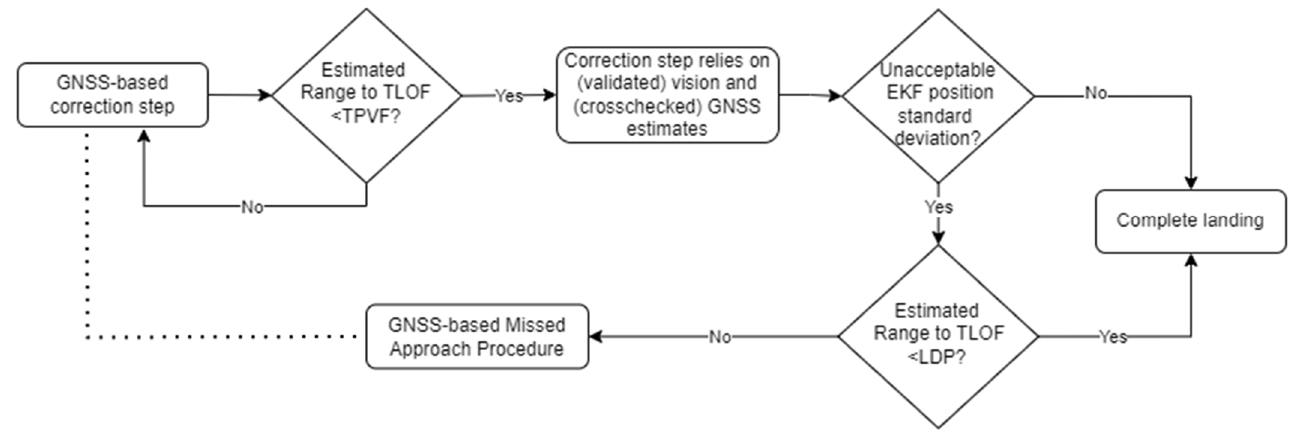
Figure 4. Flowchart of the EKF correction step algorithm.